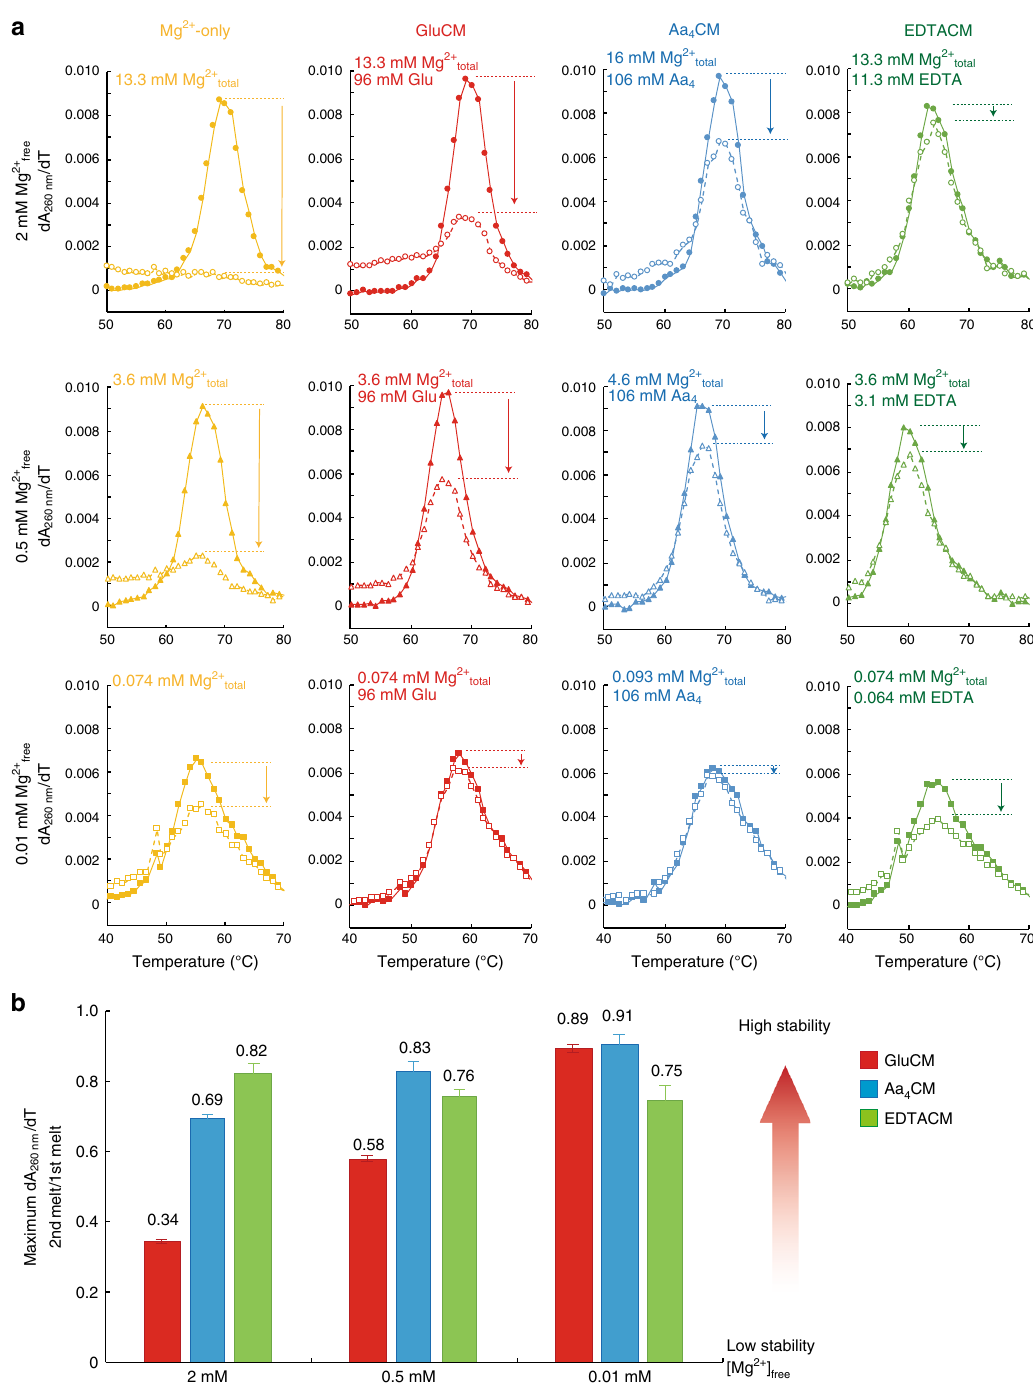
Fig. 2 Amino acid-chelated magnesium reduces RNA degradation according to thermal denaturation experiment. Successive thermal denaturation experiments are conducted using cleaved drz-spur-3 ribozyme. a Closed and open symbols indicate fi rst and second successive thermal denaturation curves, respectively. Arrows indicate decrease of the maximum dA 260nm ·dT − 1 from the fi rst melting curves to the second melting curves. Free Mg 2 + is 2 mM, 0.5 mM, or 0.01 mM, while chelated Mg 2 + was also present and achieved in different chelators as provided in the fi gure. b Summary of RNA stabilization in each condition. RNA stabilization at a given condition was estimated by dividing the maximum dA 260 nm ·dT − 1 in the second melting curves by that in the fi rst melting